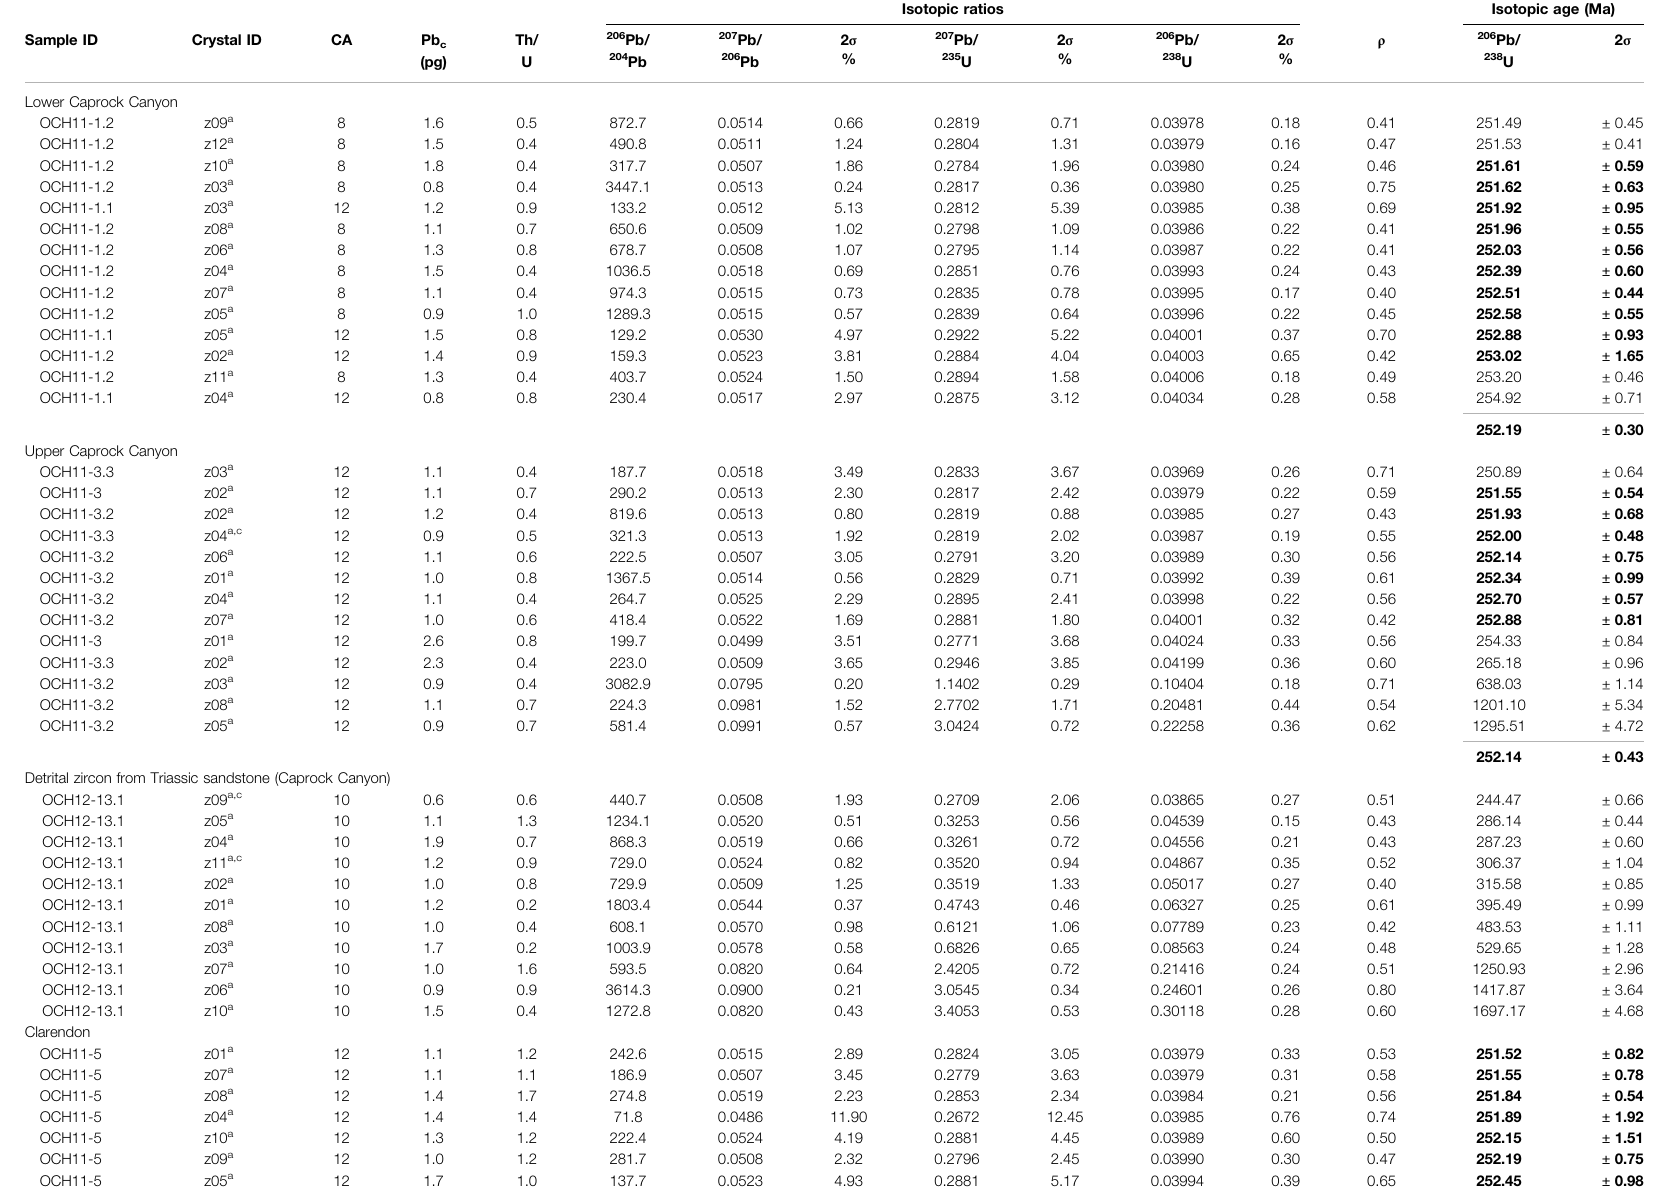
TABLE 3 | U-Pb isotopic data from individual zircon crystals from each of the sampling locations discussed in this study.